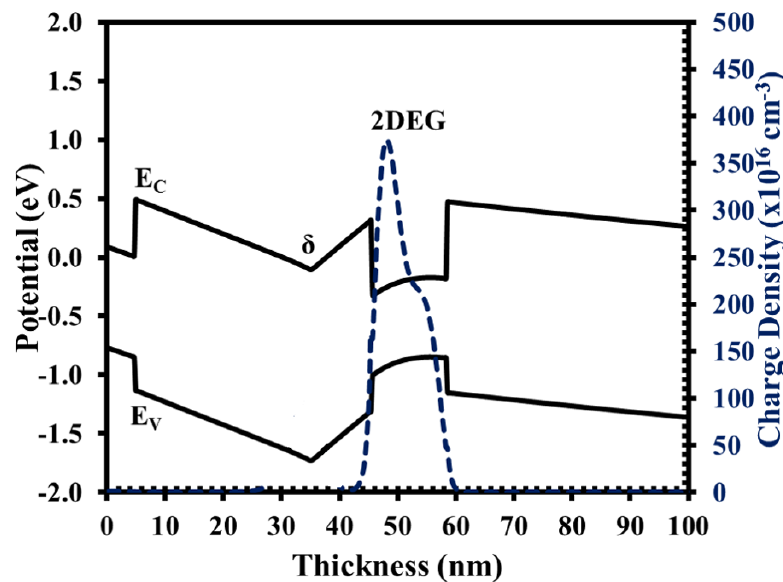
Figure 4. XMBE56 conduction band diagram and electron